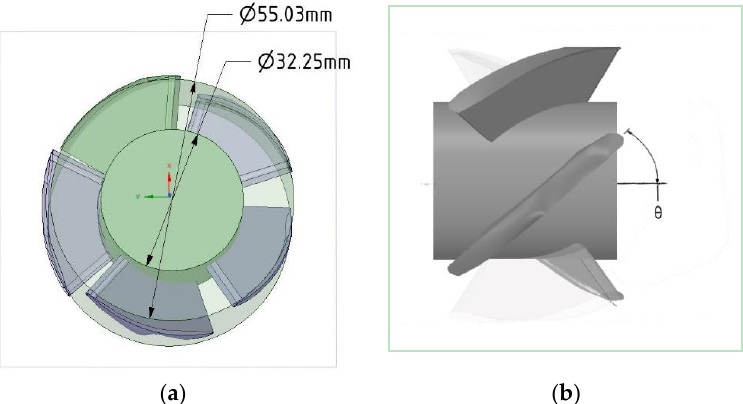
Figure 3. Drawing of the air diffuser displaying the diameters and the vane angle: ( a ) top view; ( b ) side